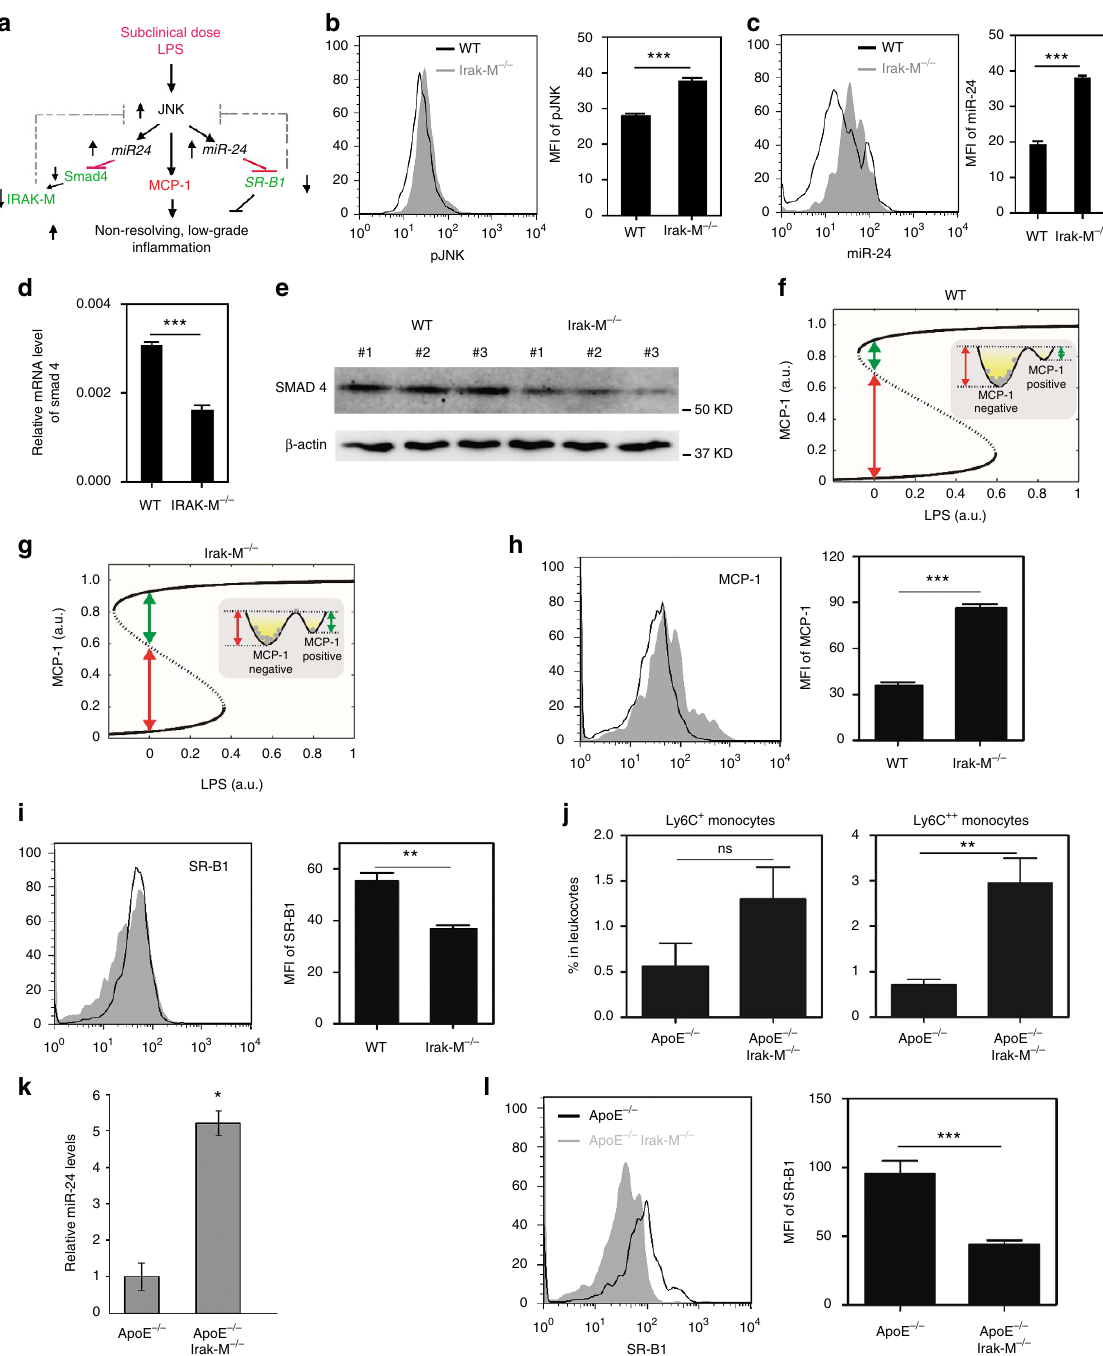
Figure 7 | Disruption of IRAK-M results in sustained pro-inflammatory programming of monocytes both in vivo and in vitro . ( a ) A schematic illustration of network dynamics underlying the establishment of non-resolving inflammation. ( b – e ) BMMs from WT C57 BL/6 mice or Irak-M (cid:2) / (cid:2) mice were cultured with M-CSF (10ngml (cid:2) 1 ) for 5 days. ( b ) JNK phosphorylation within CD11b þ Ly6C þ þ monocytes. ( c ) The levels of miR-24-3p within CD11b þ Ly6C þ þ monocytes . ( d , e ) The mRNA and protein levels of SMAD4. ( f ) The bifurcation diagram that illustrates a relatively tight suppression of MCP-1 expression in resting WT cells. Solid lines show two stable steady states (upper branch: MCP-1-positive state; lower branch: MCP-1-negative state). Dotted line is the unstable steady states. All cells reside at MCP-1-negative state because of the large energy barrier for a MCP-1-negative to MCP-1-positive state transition (red line). AU, conceptual arbitrary unit. ( g ) Deletion of IRAK-M allows leaky low-grade inflammation to occur as manifested in the leaky activation of MCP-1. Bifurcation diagram was plotted similar to ( f ). AU, arbitrary unit. ( h ) Flow cytometry analysis of MCP-1 levels within cultured CD11b þ Ly6C þ þ monocytes from WT and Irak-M (cid:2) / (cid:2) mice( n ¼ 3). ( i ) Expression levels of SR-B1 within cultured CD11b þ Ly6C þ þ monocytes from WT and Irak-M (cid:2) / (cid:2) mice ( n ¼ 3). ( j – l ) ApoE (cid:2) / (cid:2) and ApoE (cid:2) / (cid:2) / Irak-M (cid:2) / (cid:2) mice were fed with HFD for 8 weeks. ( j ) Circulating CD11b þ Ly6C þ þ and CD11b þ Ly6C þ monocytes were examined by flow cytometry. Data are shown from ApoE (cid:2) / (cid:2) ( n ¼ 5) and ApoE (cid:2) / (cid:2) / Irak-M (cid:2) / (cid:2) ( n ¼ 6) mice. ( k ) The expression levels of miR-24 from splenocytes were analysed between ApoE (cid:2) / (cid:2) ( n ¼ 4) and ApoE (cid:2) / (cid:2) / Irak-M (cid:2) / (cid:2) ( n ¼ 4) mice. ( l ) The expression levels of SR-B1 within circulating monocytes were analyzed between ApoE (cid:2) / (cid:2) ( n ¼ 5) and ApoE (cid:2) / (cid:2) / Irak-M (cid:2) / (cid:2) ( n ¼ 6) mice. All data are representative of at least two similar experiments. Error bars show means ± s.e.m.; NS, not significant; ** P o 0.01 and *** P o 0.001; Student’s t -test. NATURE COMMUNICATIONS|7:13436|DOI: